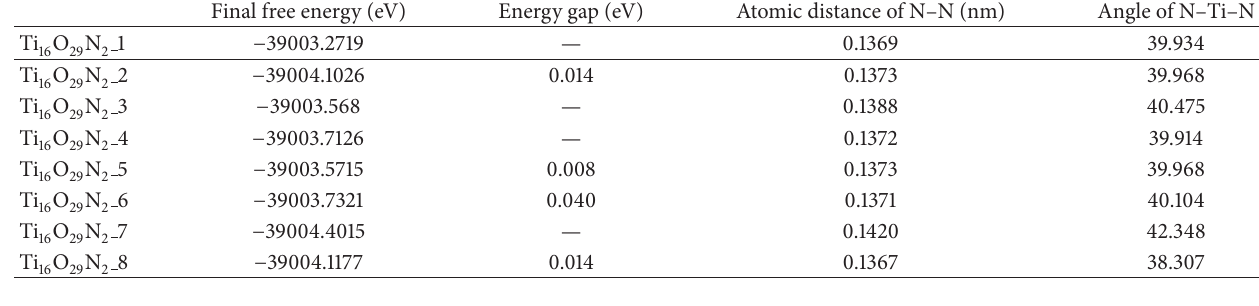
and the bond distance between the two doped 2